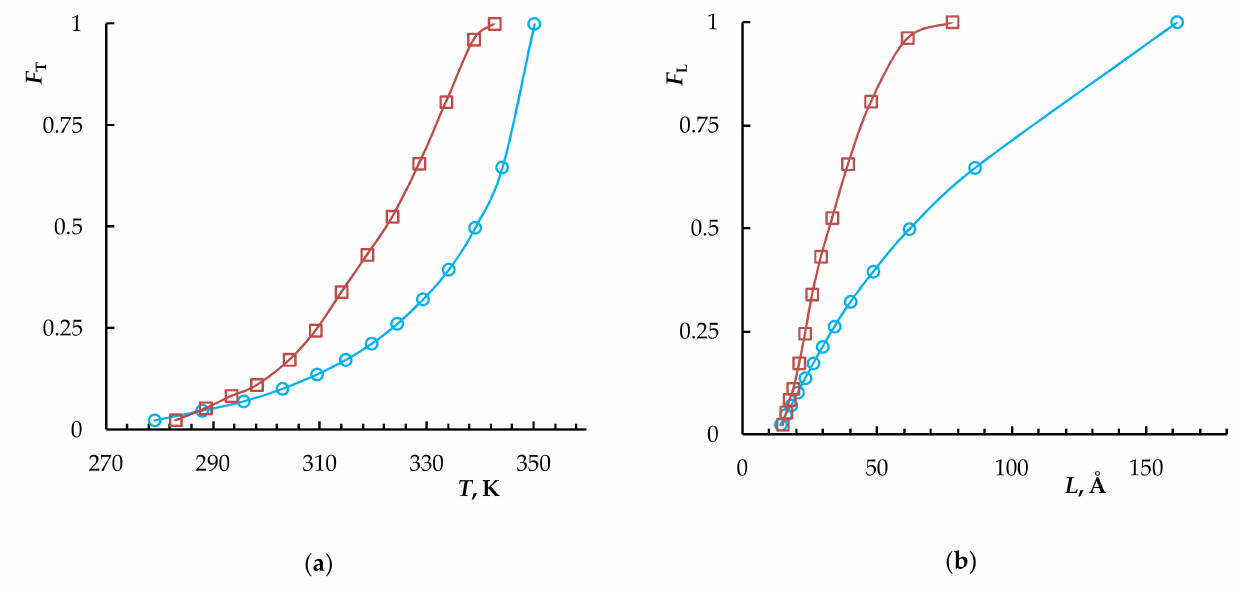
Figure 7. Integral distribution functions for the ( a ) melting temperature and ( b ) lamella thickness of crystallites in thermally fractionated NB–CDD (blue) C1 and (brown) C4